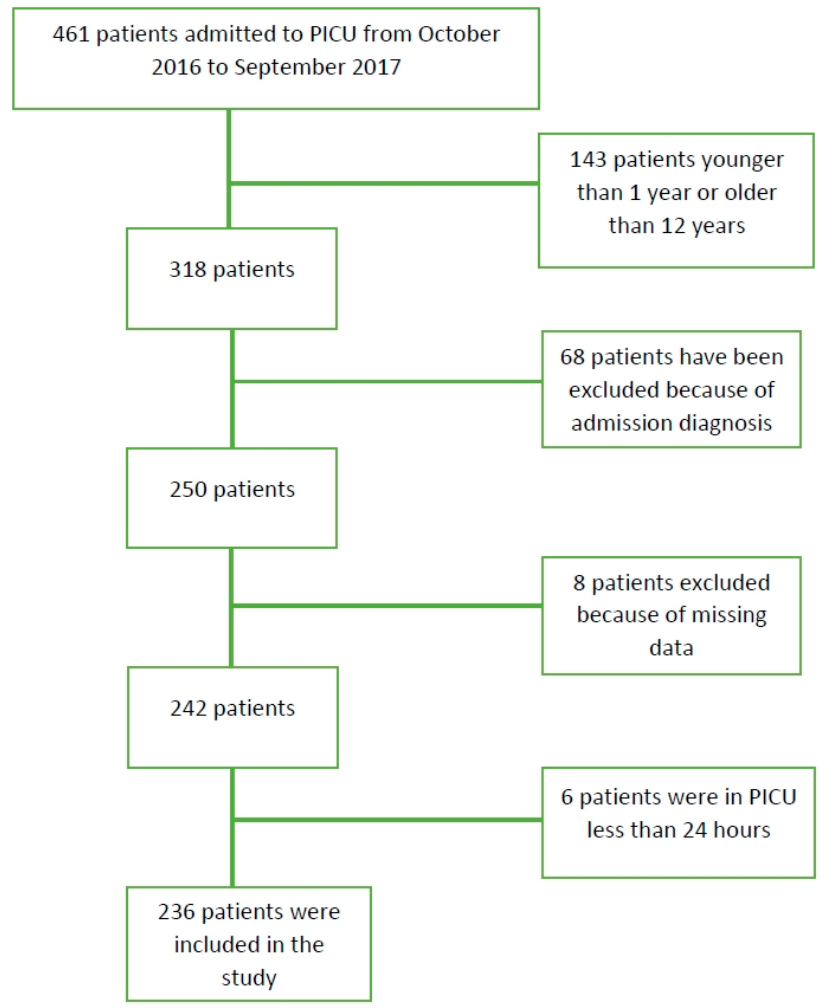
Figure 1. Cohort flow.